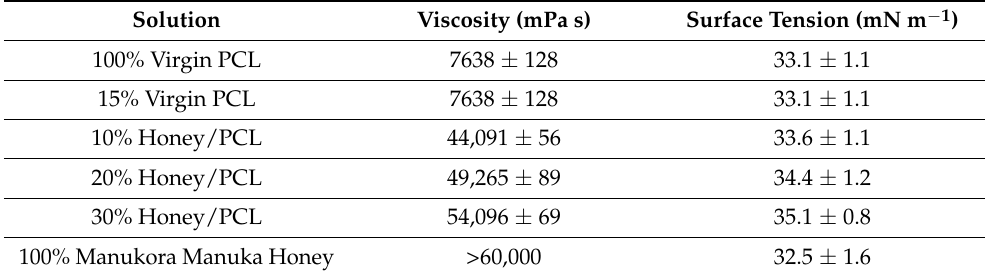
Table 3. Viscosity and surface tension of the studied polymer solutions and manuka honey. In all cases, the PCL solution consisted of a 15% ( w / v ) concentration. The solution represents the ratio of honey to PCL